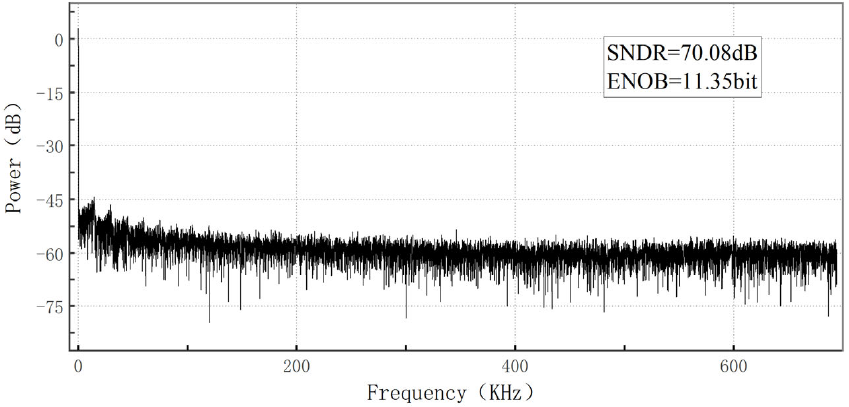
Figure 14. Signal to noise ratio analysis.